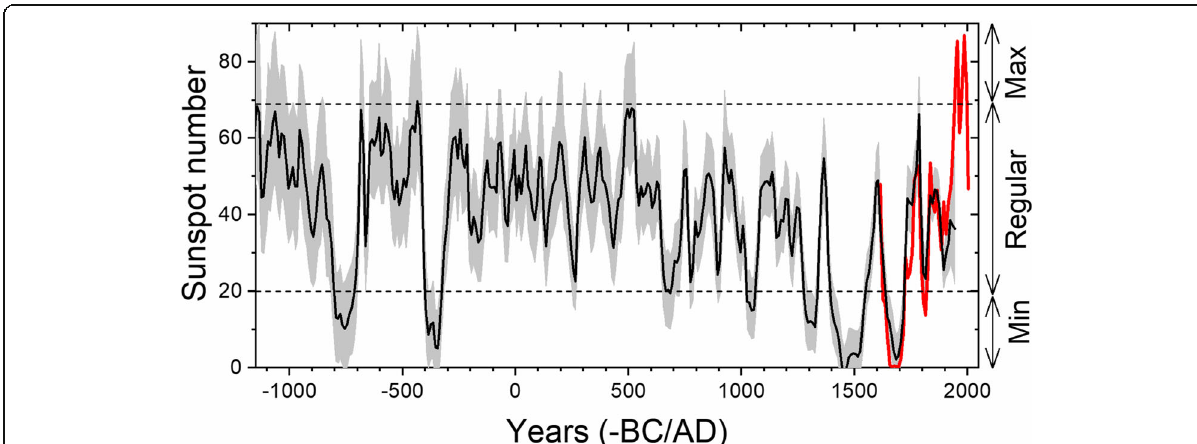
Fig. 6 Solar activity reconstruction over the past 3000 years shows a few extreme activity phases during which the sunspot cycle amplitudes persistently exceed (grand maxima) or fall below (grand minima) the typical activity levels (denoted within the two dashed lines). Following the Maunder minimum (1645 – 1715) and Dalton minimum (1790 – 1830), a growth in general activity levels resulted in the modern maximum. Solar cycle 24 however was very weak and cycle 25 is expected to be a below average cycle too. Further in the past, other grand maxima and minima episodes are observed indicating extreme activity levels have occurred over the recent history with no apparent regularity. Adapted from